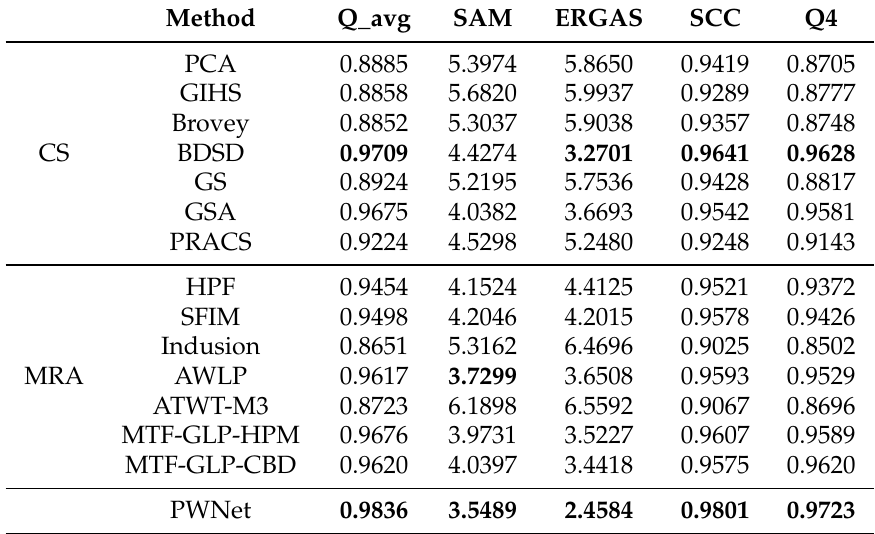
Table 5. Quantitative comparison of the CS-based and MRA-based methods and the proposed PWNet method on the WorldView-2 images. The best and second best results are highlighted in bold.